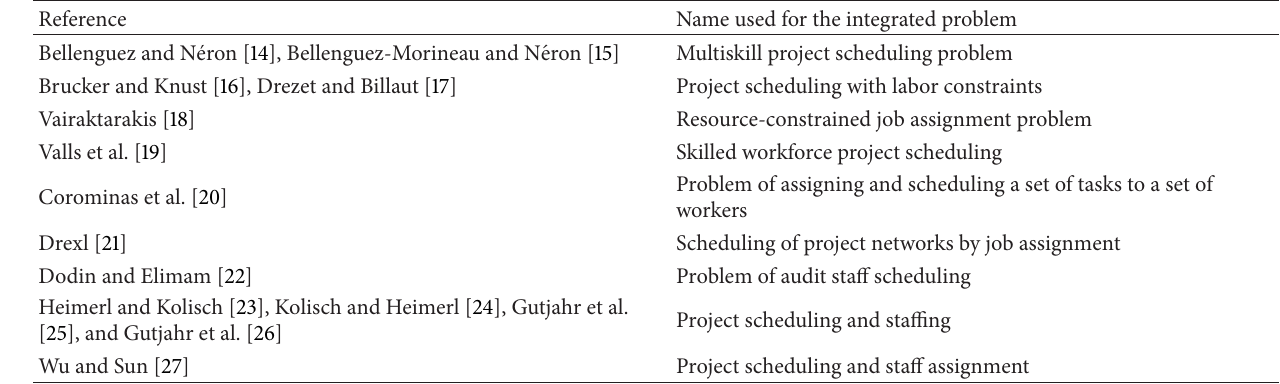
Table 1: Names for the integrated